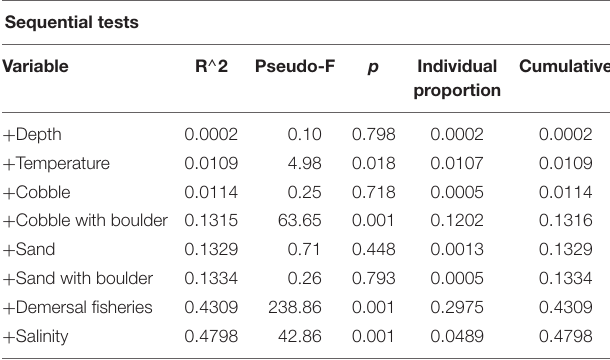
TABLE 5 | Outcome of distance-based linear modeling on the role of environmental parameters in the variation of density of sponge morphotypes. Sequential